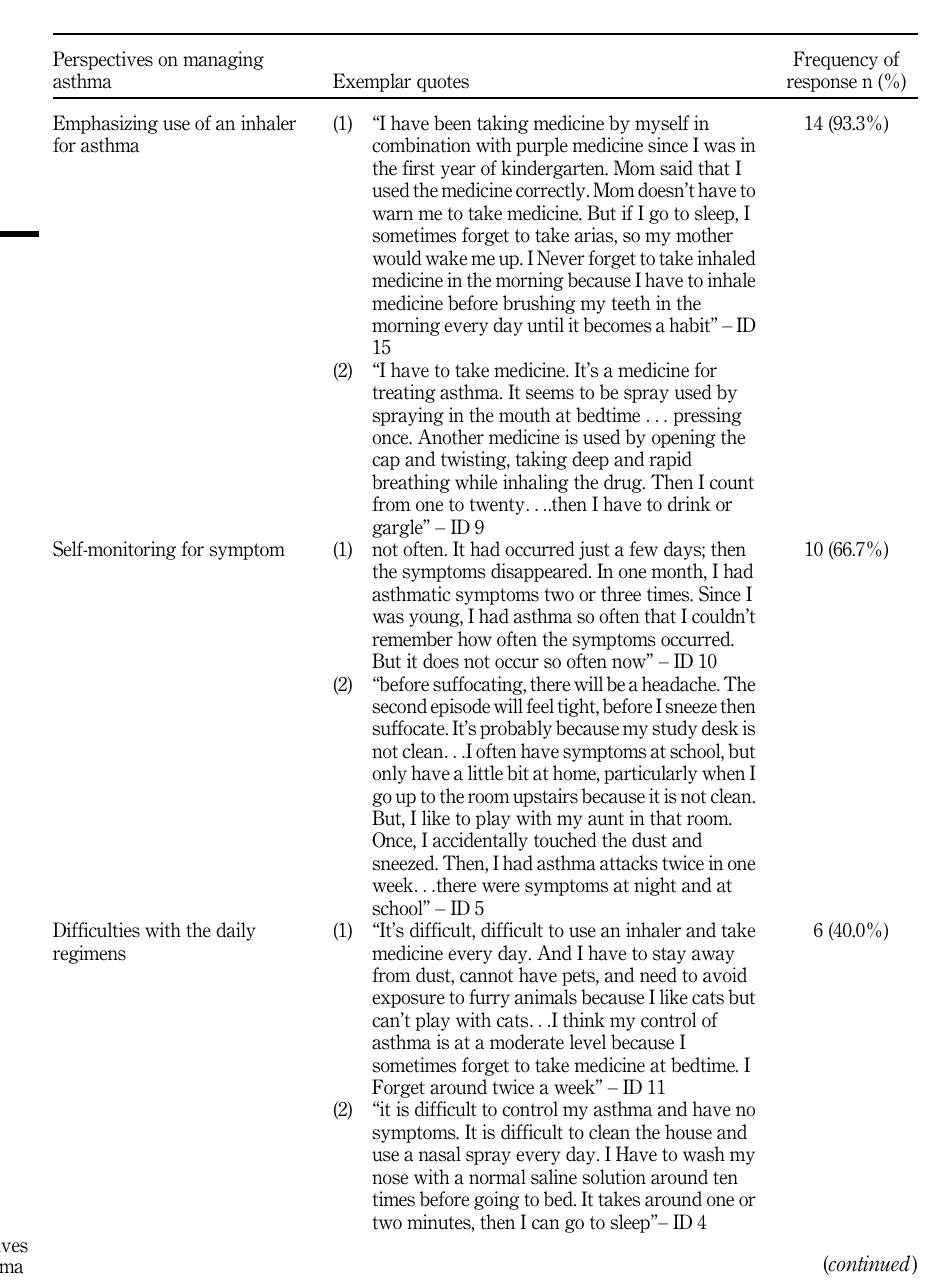
characterizing the theme of perspectives on managing